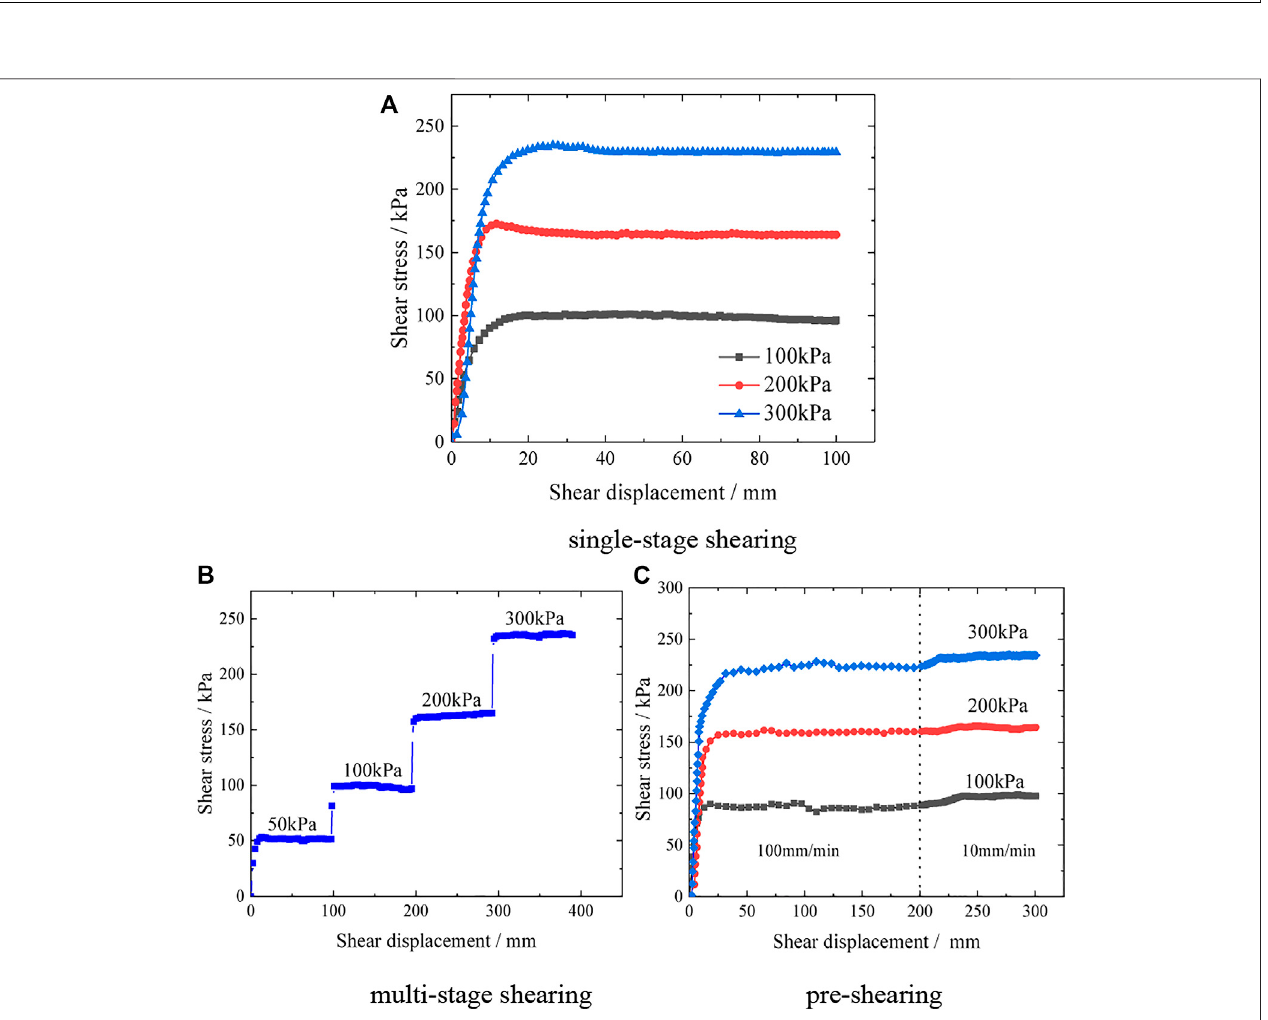
FIGURE 12 | Shear stress-shear displacement relation curve under different shear method. (A) single-stage shearing (B) multi-stage shearing (C) pre-shearing.